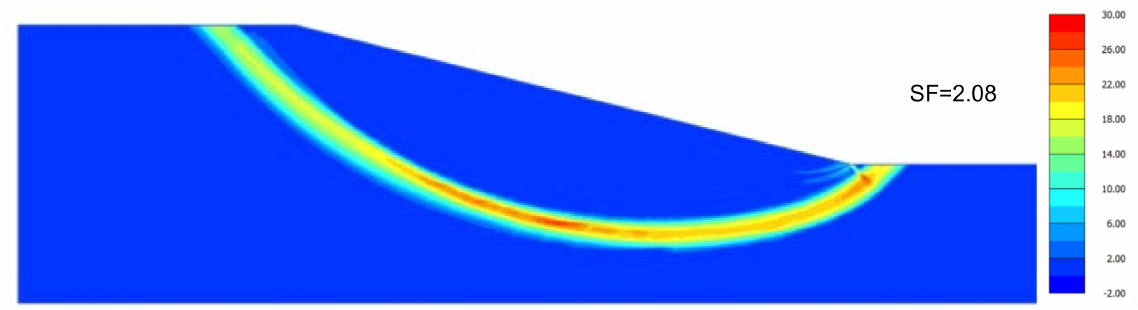
Figure 8. Failure surface characterized by large shear strains for the reference slope.